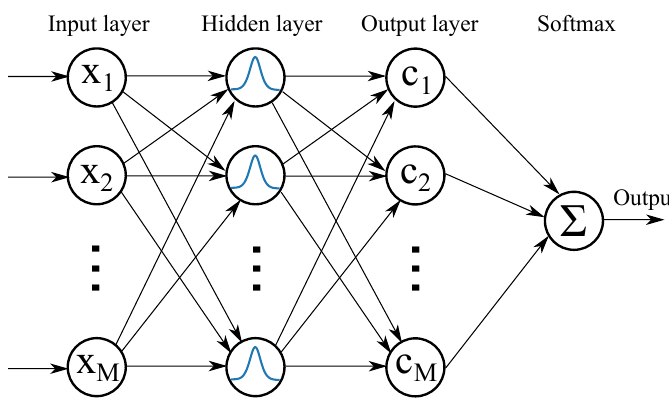
Figure 37. A generic Radial Basis Function Neural Network